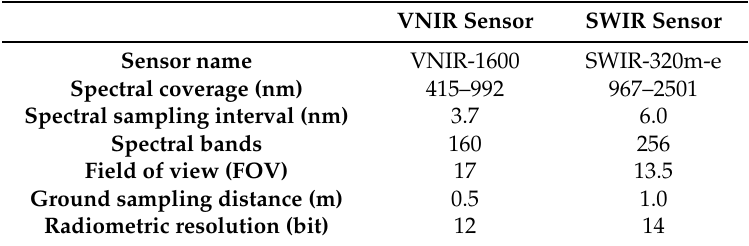
Table A2. Technical characteristics of spectral sensors used in the study.